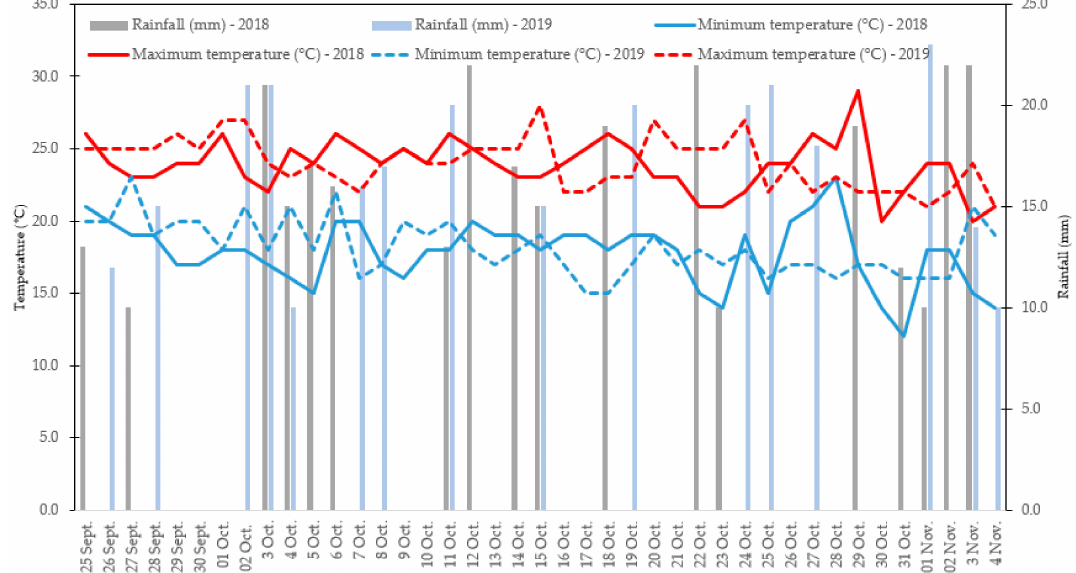
Figure 2. Daily temperature (maximum and minimum) and rainfall from 25 September to 4 November (2018 and